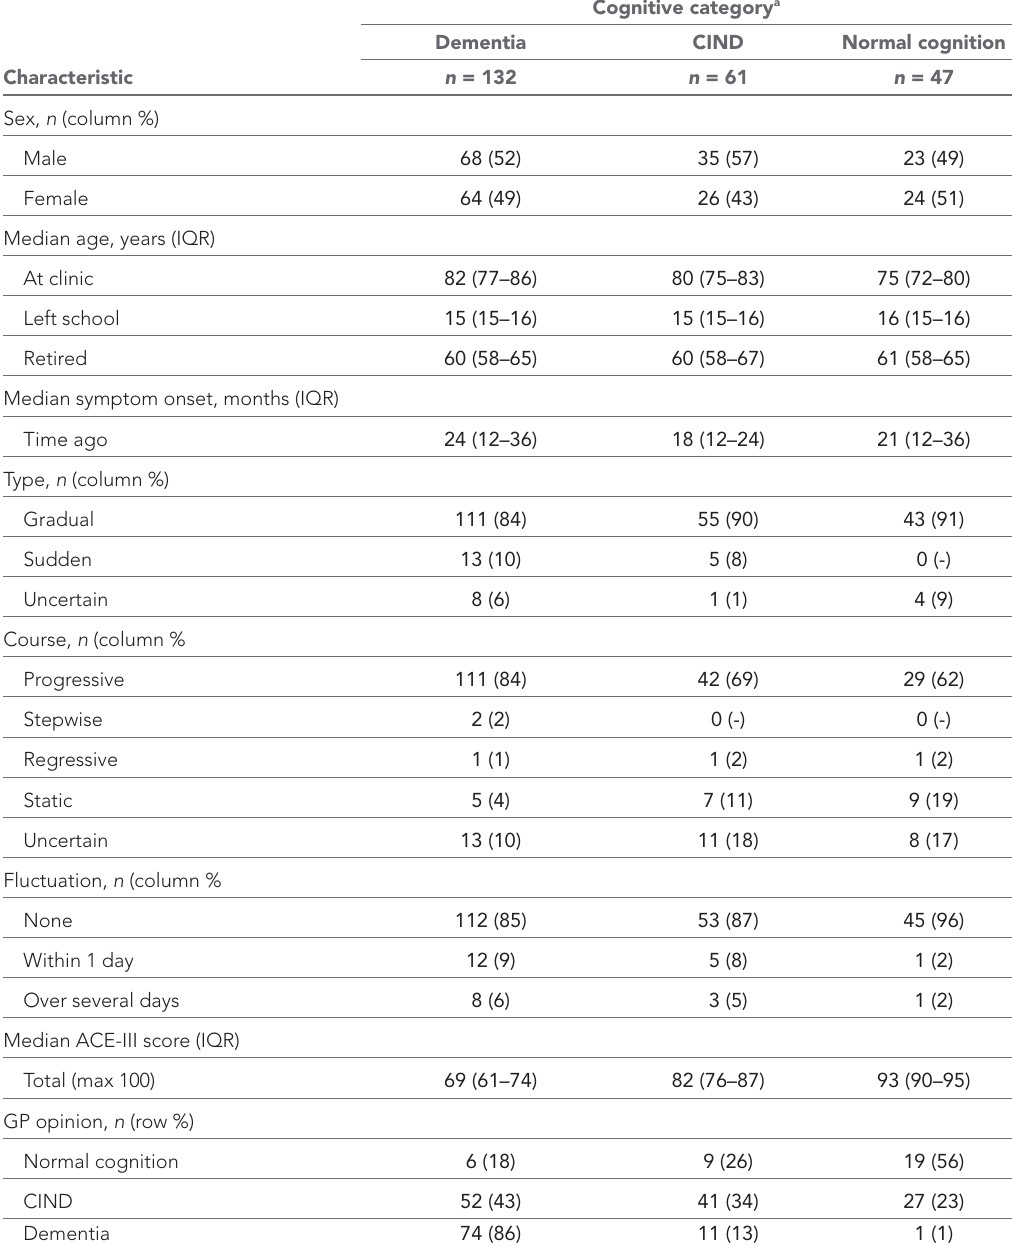
Table 1 Characteristics of participants by cognitive category